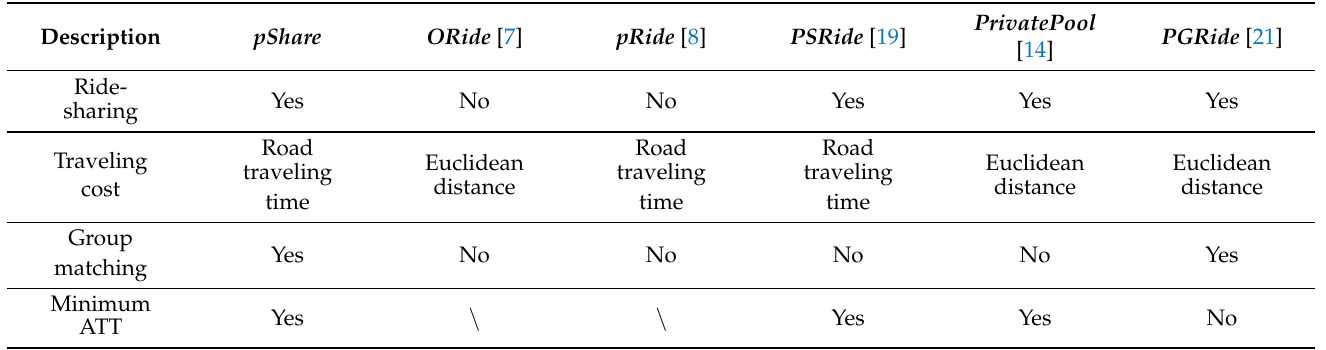
Table 1. Comparison with existing